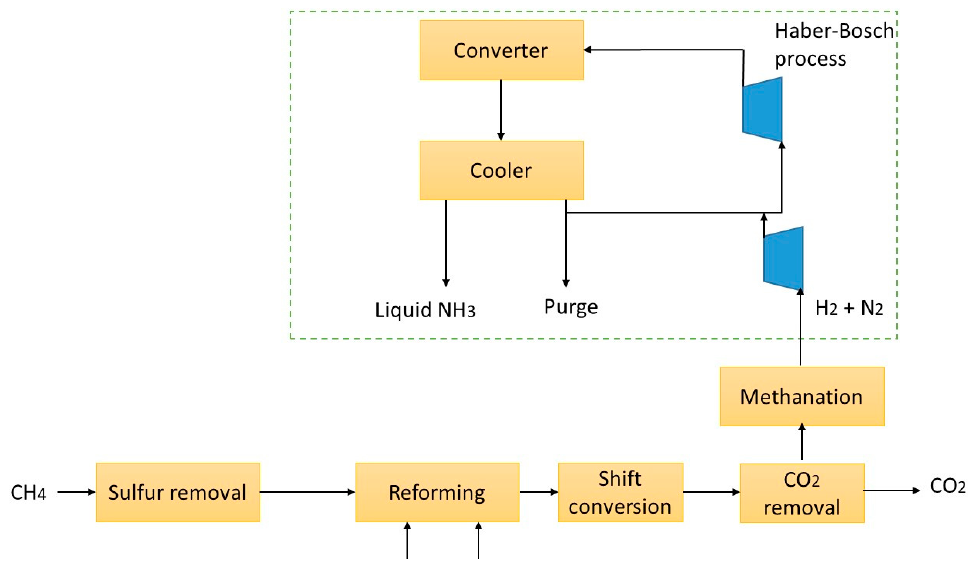
Figure 2. Industrial process for ammonia synthesis from natural gas [16].